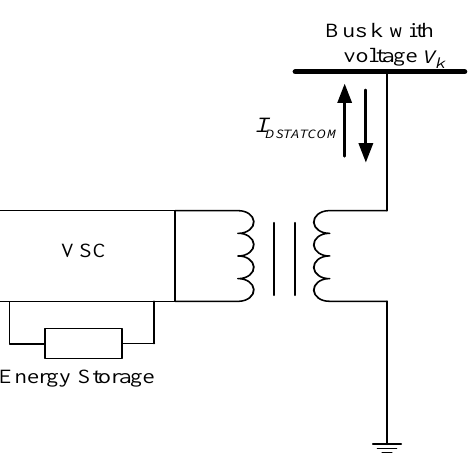
Figure 2. Typical Representation of DSTATCOM connected to k th Bus.